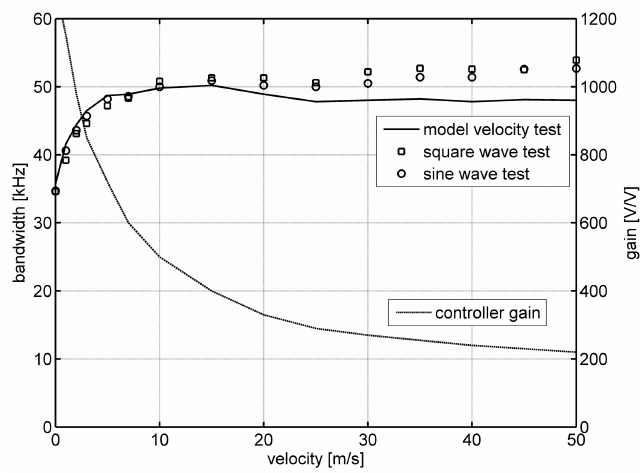
Figure 4. The measured dependence of the bandwidth of a constant-temperature constant-bandwidth anemometer on flow